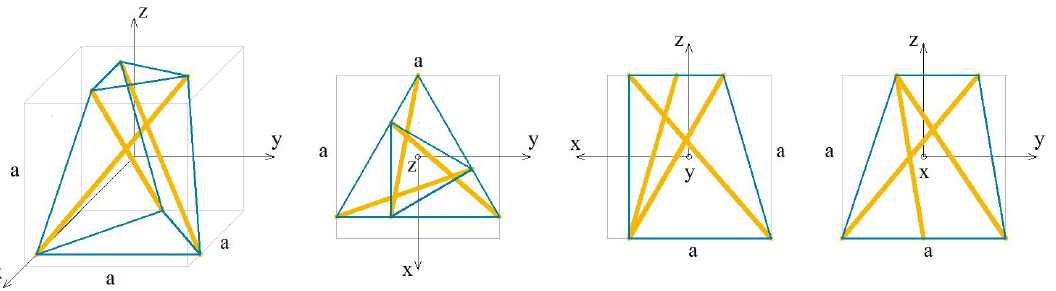
Figure 7. Geometry of the 3-strut simplex